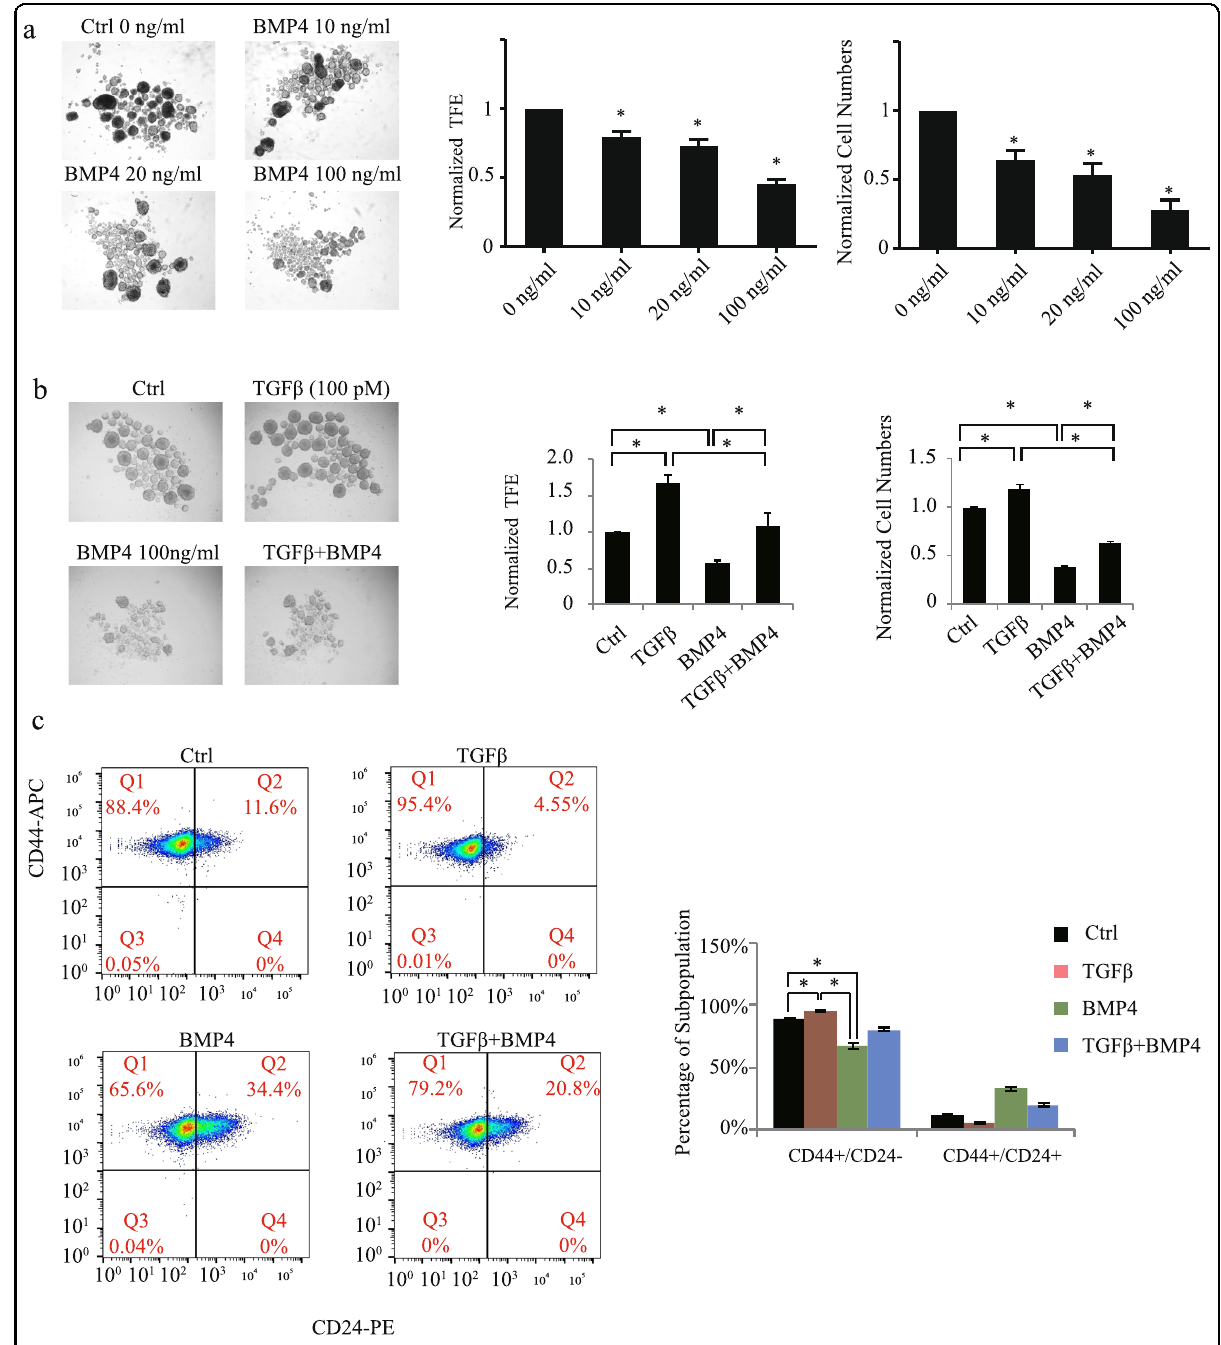
Fig. 4 BMP4 acts as a differentiation factor and inhibits TGF β -induced stemness. Tumorsphere formation assay showing that BMP4 inhibits basal ( a ) and TGF β -induced ( b ) cancer stem cell activity. Data represent means ± SEM of triplicate experiments. * P ≤ 0.05. c Flow cytometry to assess TGF β and BMP4 effects on CD44 high /CD24 − /low CSC numbers. Data represent means ± SEM of triplicate experiments. * P ≤